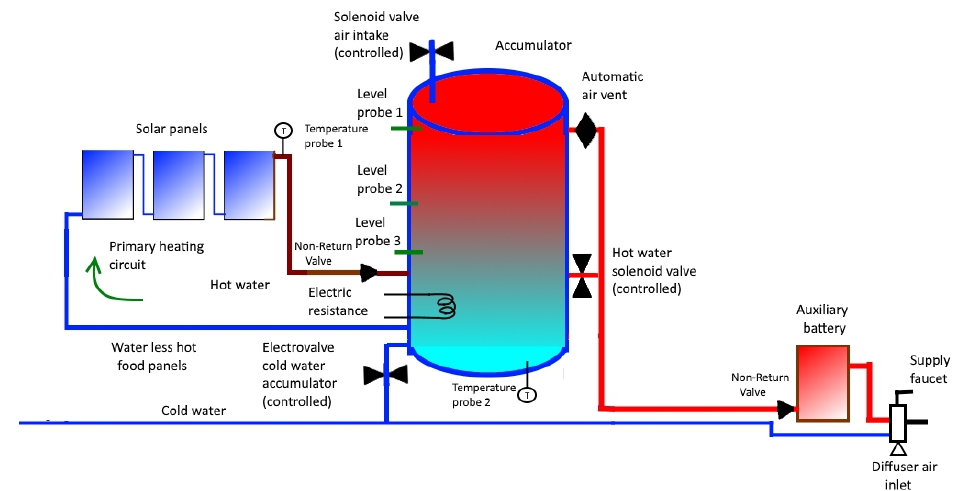
Figure 4. Functioning scheme